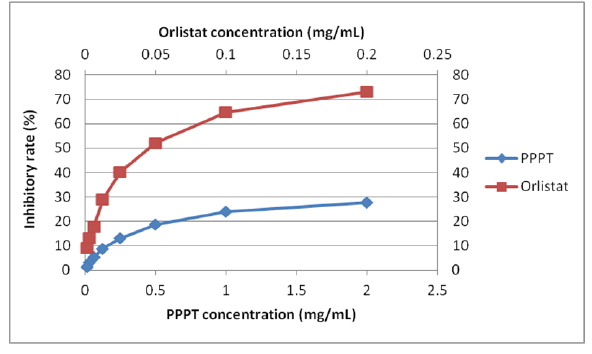
Figure 3. Inhibitory activity against α -glucosidase in vitro.